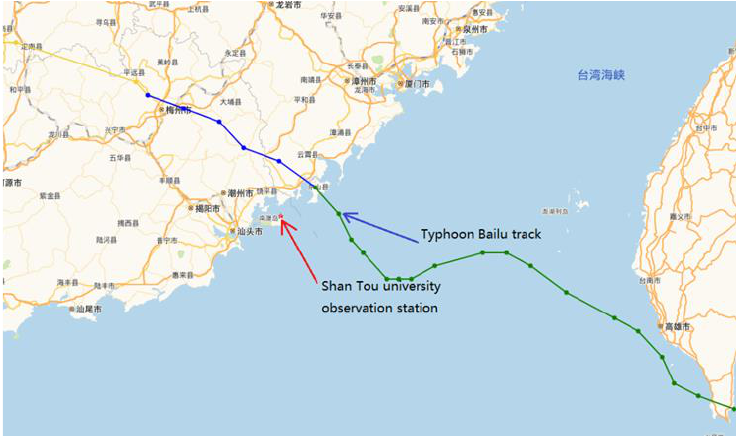
Figure 2. Typhoon Bailu track and its relative position with observation station.